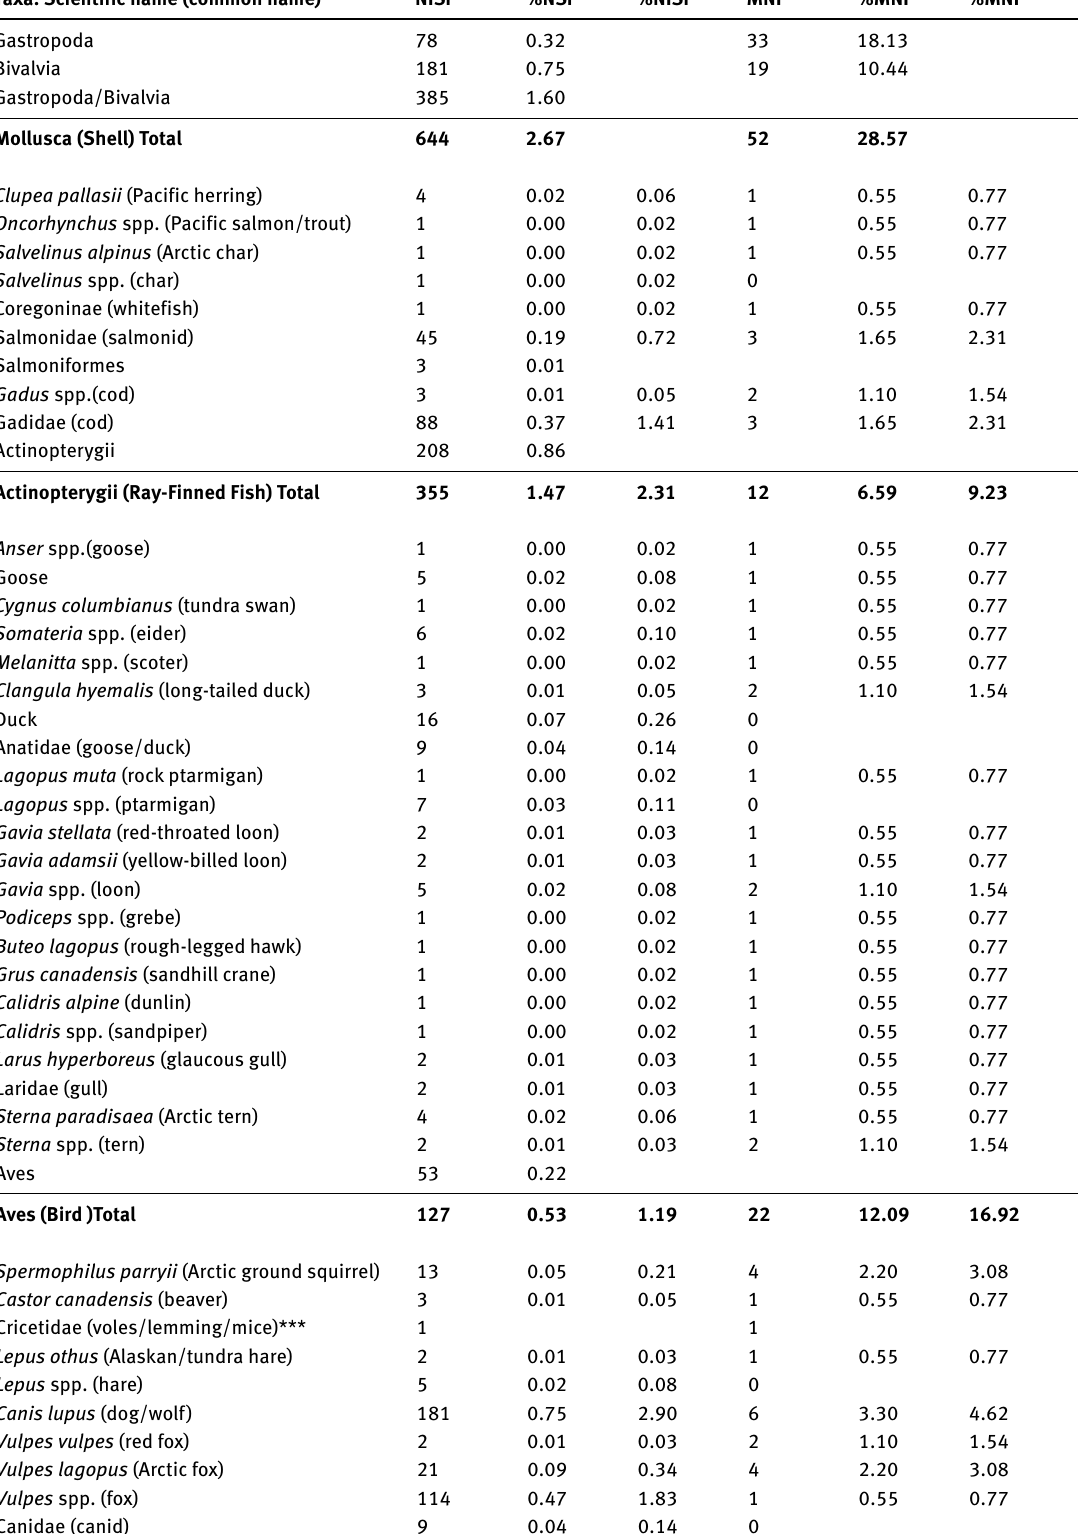
Table 3: Taxonomic frequencies. Class %NISP is the percentage of each class within specimens identified to class and lower; taxon %NISP is the percentage of each taxon within its